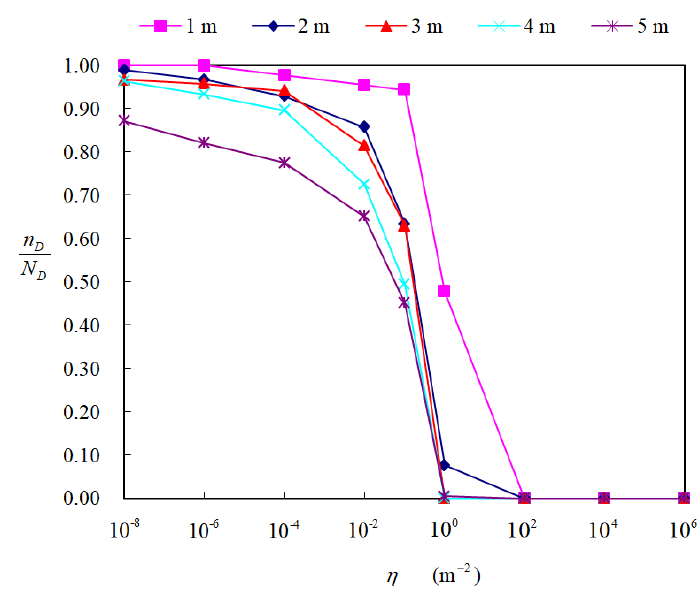
Figure 5. The value of n D / N D for eight different thresholds η and five different distances from the source.